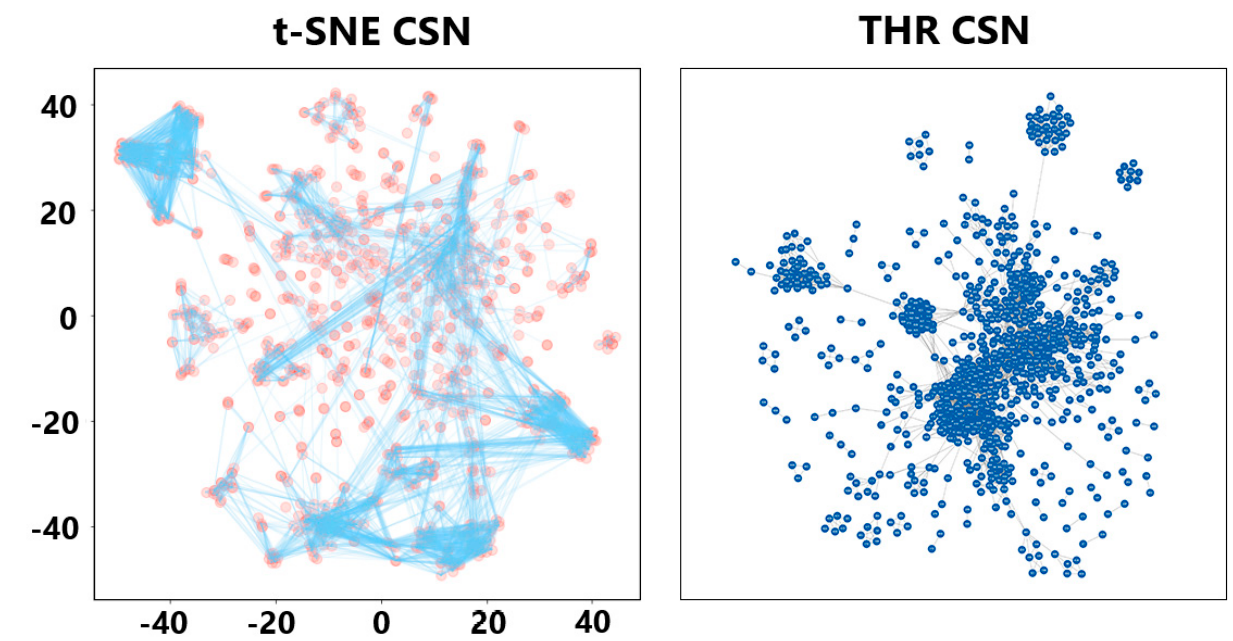
Figure 7. t-SNE CSN and THR CSN for the bitters dataset. Molecules in the t-SNE CSN are repre- sented by red circles, and edges with a similarity greater than 0.45 are indicated in blue. In the THR CSN, molecules and edges are represented as blue circles and black lines, respectively.